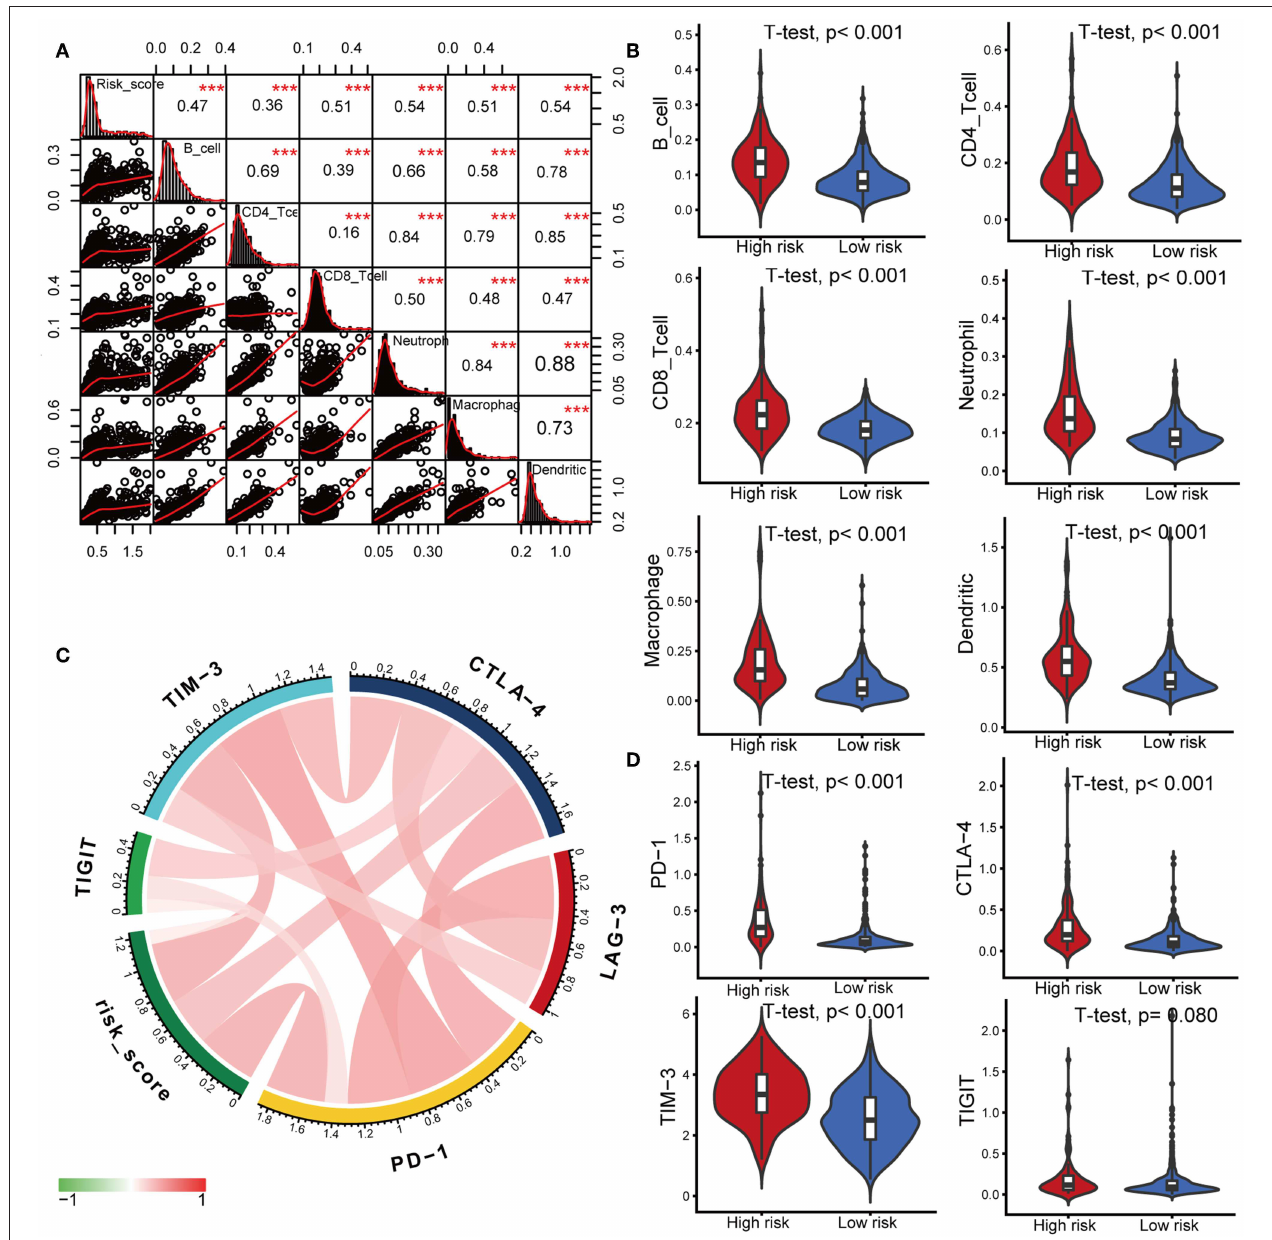
FIGURE 6 | Correlations of the IPS with infiltrating immune cell proportions and immune checkpoints. (A) Correlation of the risk score with infiltrating immune cell proportions. Pearson’s correlation coefficient values with the level of significance were shown on the top of the diagonal. *** P < 0.001. (B) Violin plots visualizing significantly different immune cell proportions between high- and low-risk patients. (C) Correlation of the risk score with the expression of several crucial immune checkpoints (D) Violin plots visualizing significantly different immune checkpoints between high- and low-risk patients.